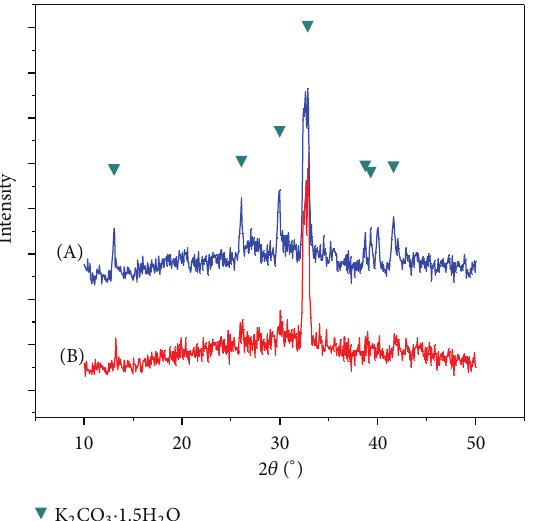
Figure 6: XRD patterns of the feedstock with K 2 CO 3 of 10%: (a) before reaction; (b) after reaction.